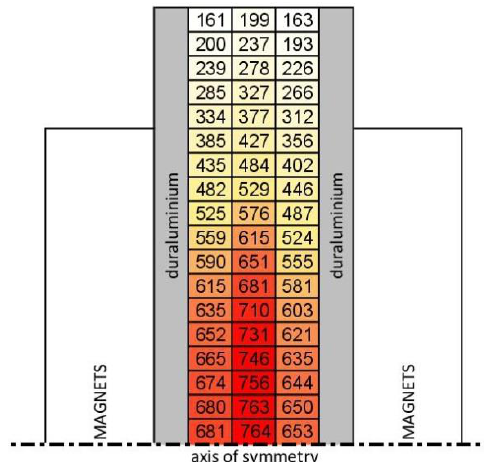
Figure 16. The results of induction distribution measurement in the machining gap [×10 −3 T]. The distance between magnets amounts to 28 mm.